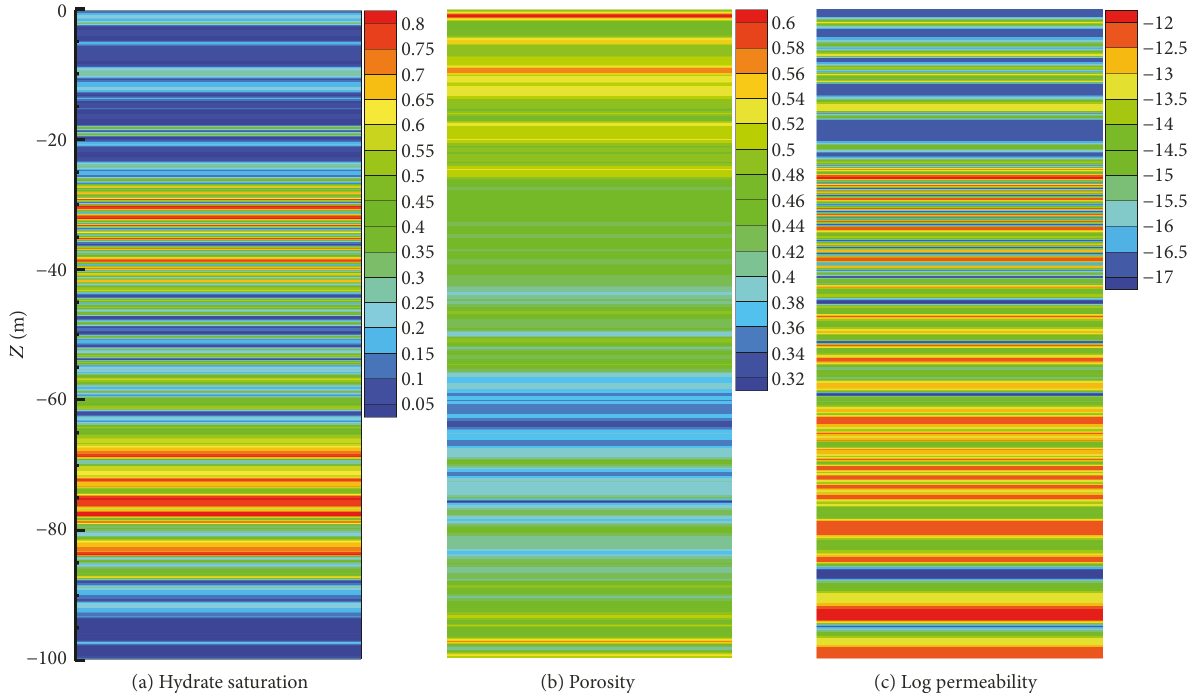
Figure 6: Cross-sectional view showing the initial reservoir-model properties: (a) hydrate saturation, (b) porosity, and (c) logarithmic value of absolute